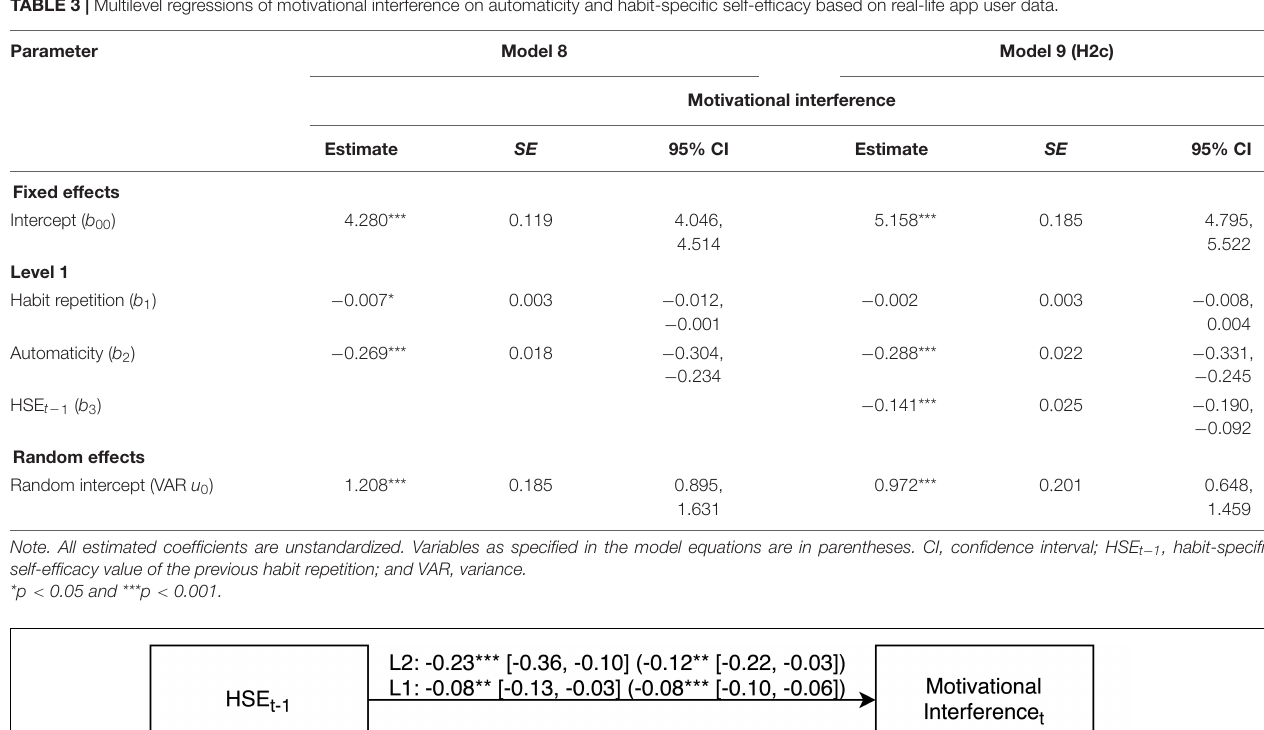
TABLE 3 | Multilevel regressions of motivational interference on automaticity and habit-specific self-efficacy based on real-life app user